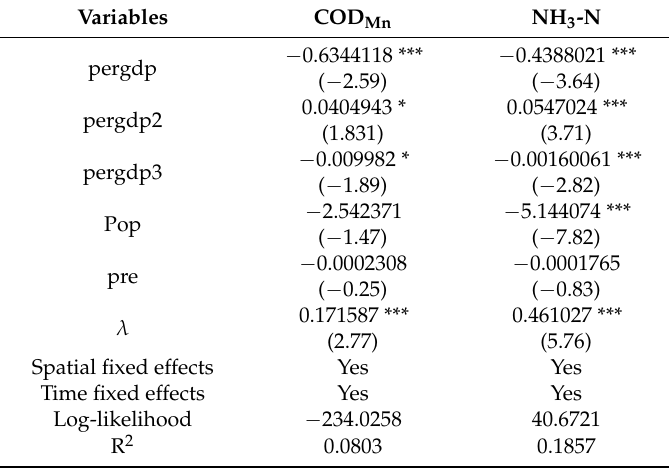
Table 7. Impact of the economy on the environment.